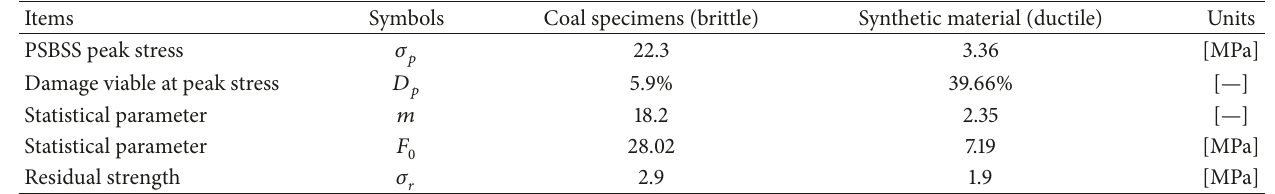
Table 2: Parameters derived from the proposed